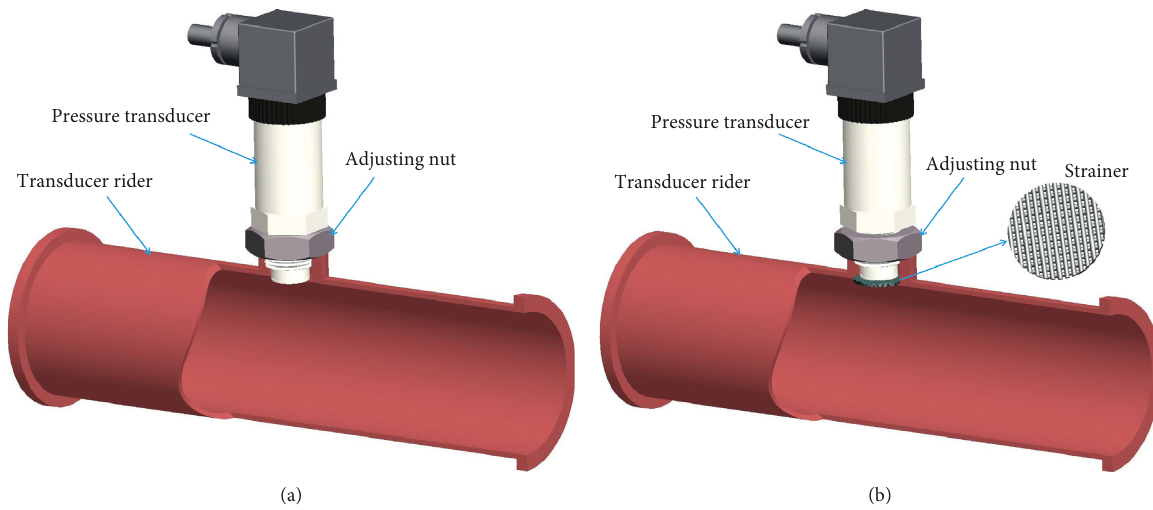
Figure 3: Installation structure of the pressure transmitter on lines. (a) Standard installation structure of the pressure transmitter. (b) Installation structure of the pressure transmitter with strainer.